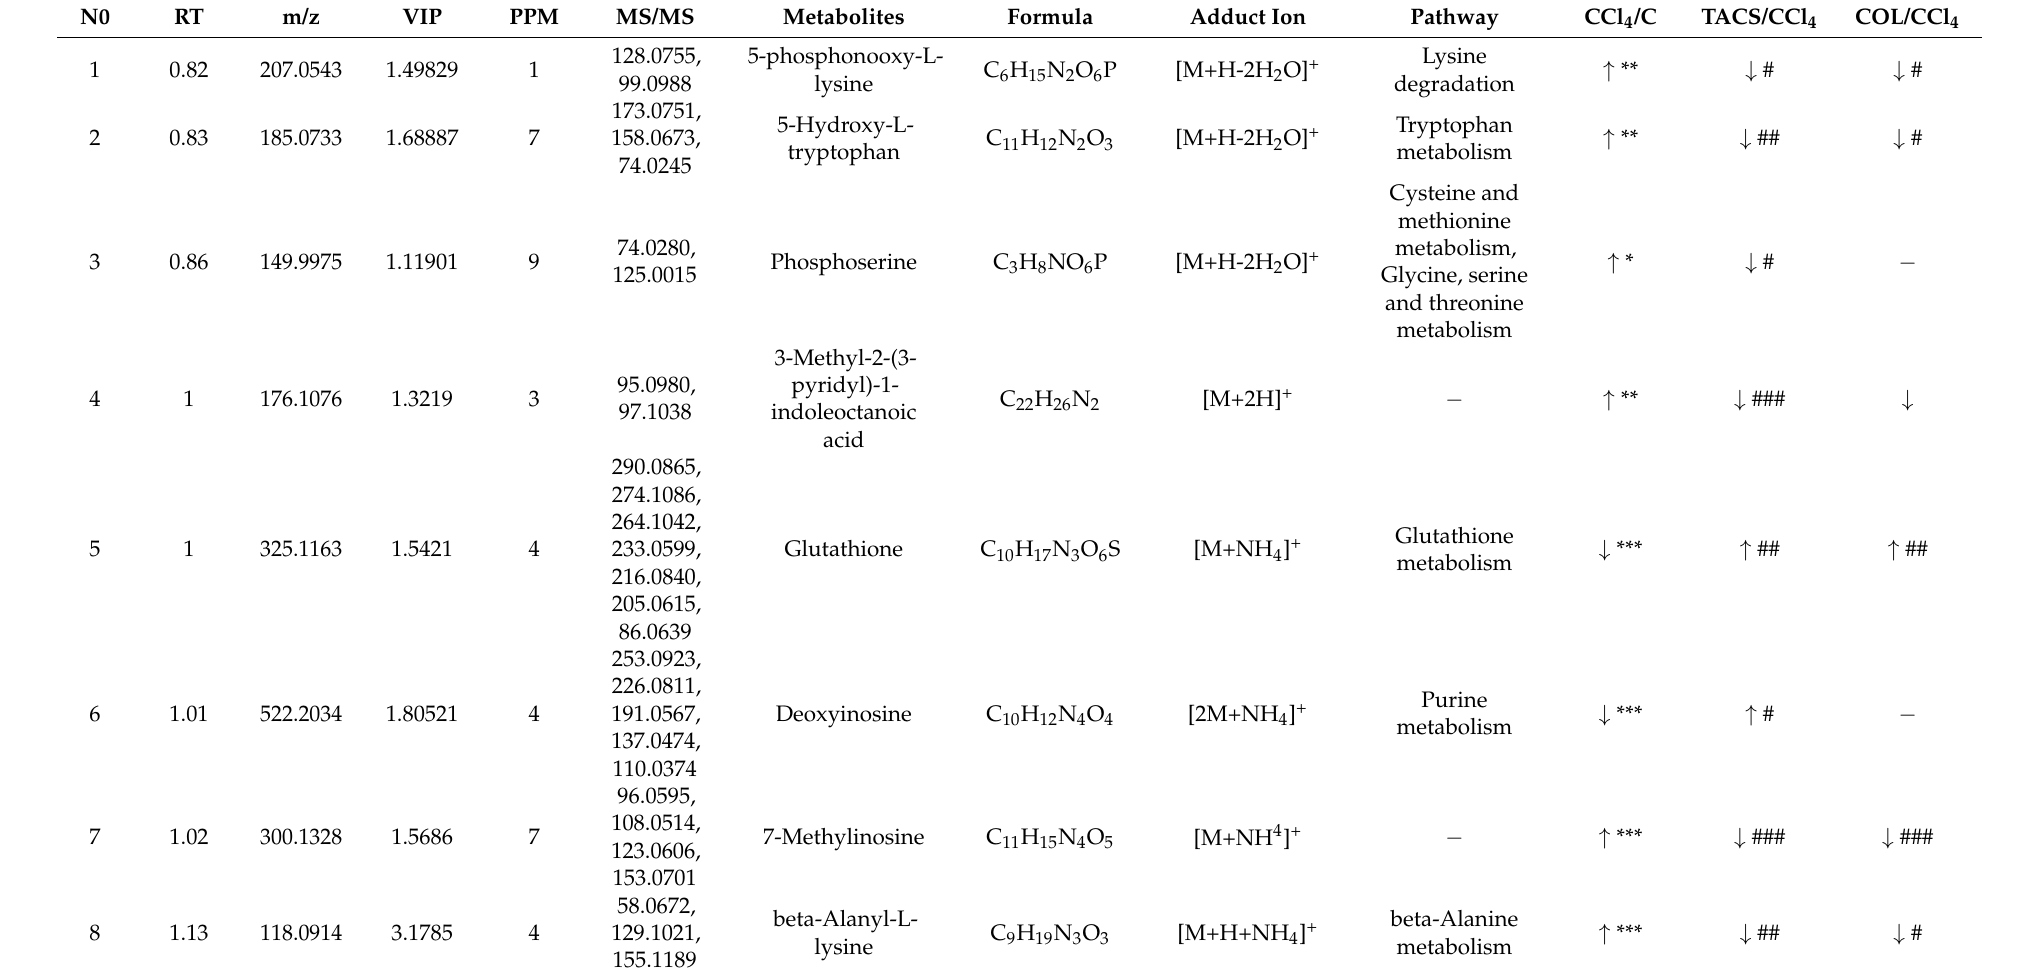
Table 1. The potential biomarkers of feces in liver fibrosis rats ( n =